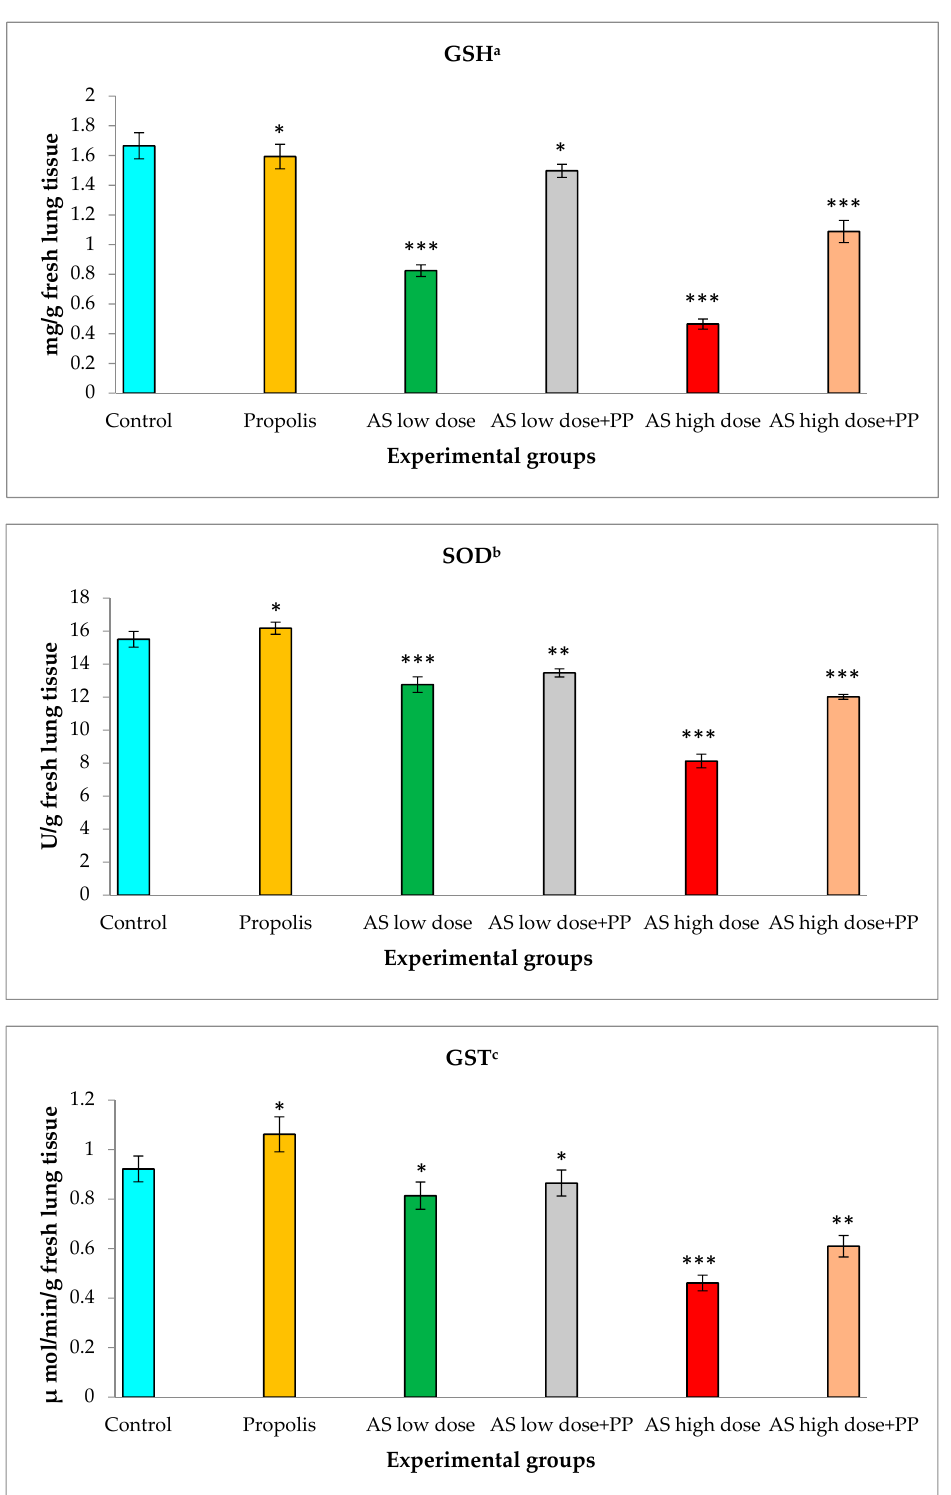
Figure 1. Estimation of biochemical oxidative stress in rat lungs in the di ff erent animal groups: ( a ) glutathione reductase (GSH); ( b ) superoxide dismutase (SOD); ( c ) glutathione s-transferase (GST). *—Non-significant, **—Significant, ***—Highly